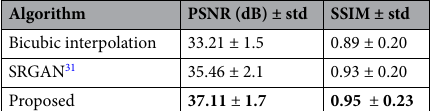
Table 8. Results on ultrasound images. Significant values are in [bold].